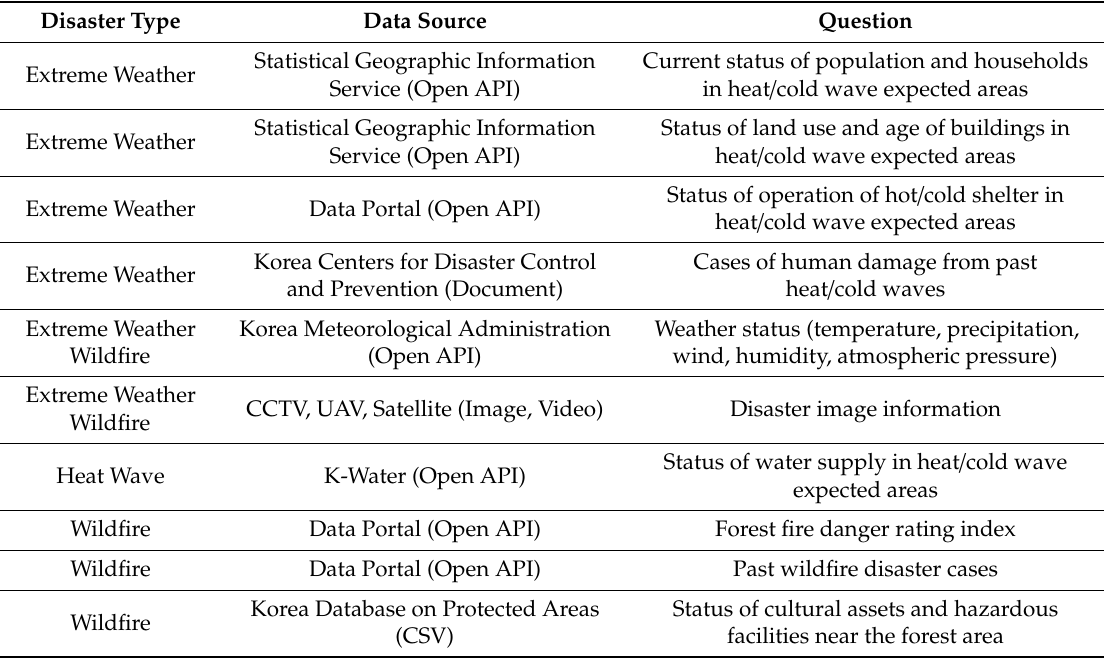
Table 1. Questions and data sources required for disaster response (Application Programming Interface (API), Closed-Circuit Television (CCTV), Unmanned Aerial Vehicle (UAV)).